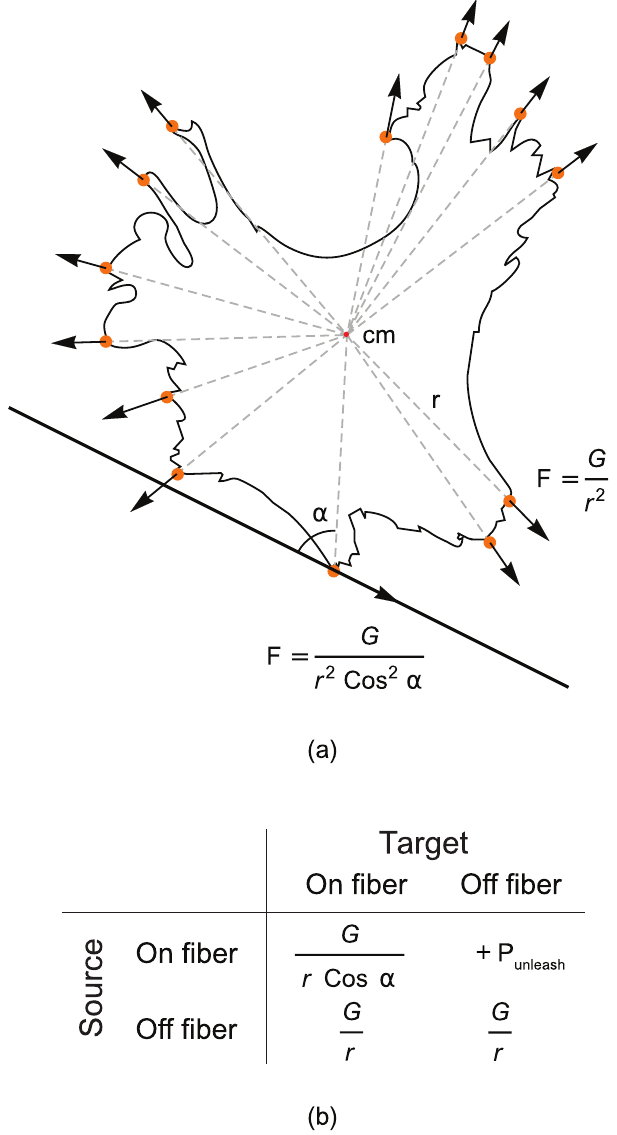
Figure 7. Schematic representation of cell spreading and cell–nanofibre interaction. ( a ) The cell shape was taken from the experimental database. All protrusions are marked with orange circles. Arrows show the direction of the resulting force driving the cell expansion at the attachment sites. If no guiding fibres exist, the cell spreads equidirectionally, and the forces are directed from the centre of mass of the cell (cm). If a nanofibre exists (at the bottom), and the cell is already attached to it, then the force is aligned with the fibre. ( b ) Energy terms, applied for different copy attemts of the attachment site to the non-attachment subcell, from the isotropic sibstrate to the fiber or in opposite